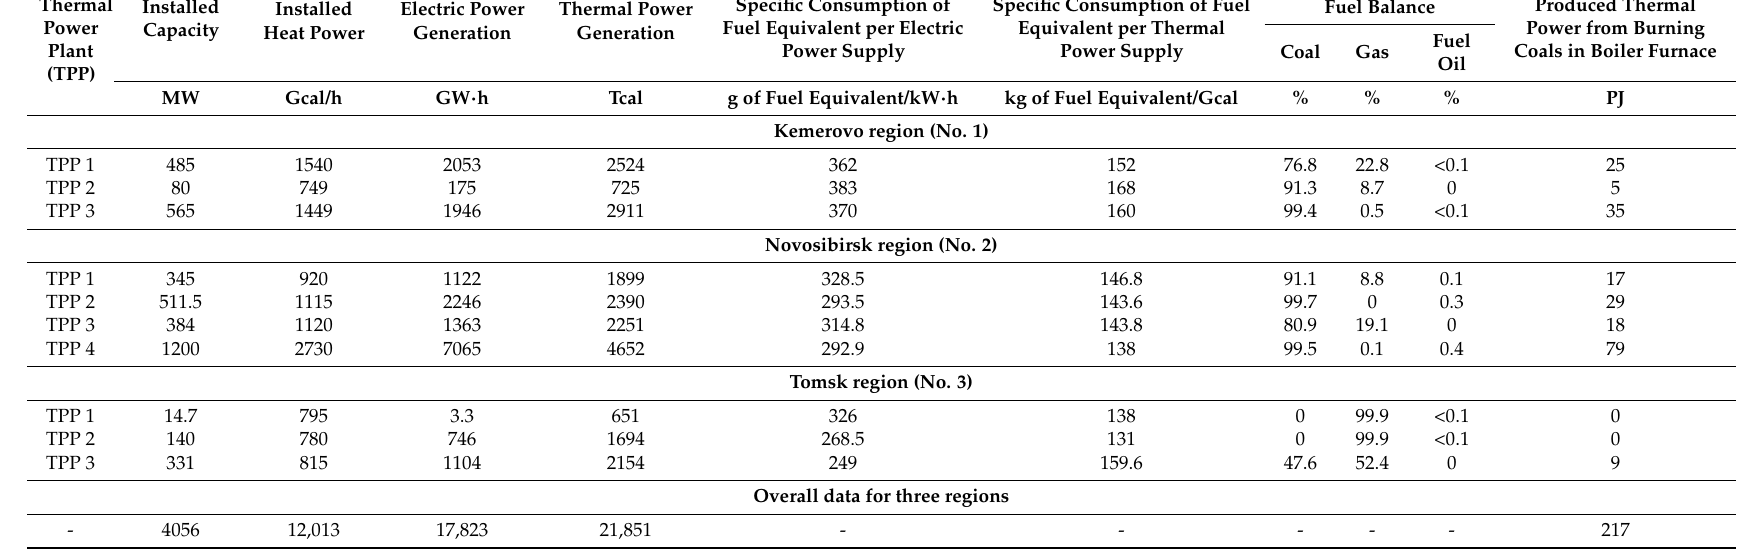
Table 8. Specifications of thermal power plants